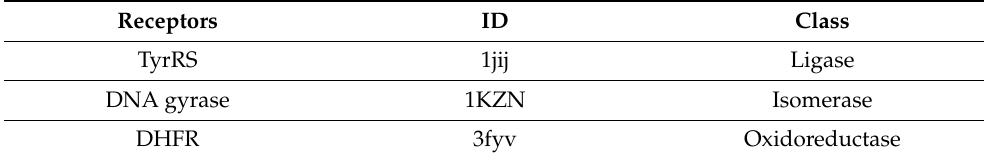
Table 1. Description of the studied receptors. Receptors ID Class TyrRS